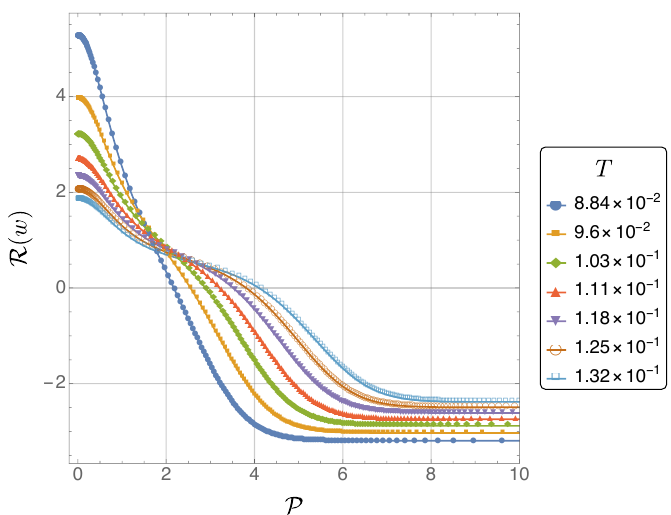
Figure 17 . Curvature of the induced horizon geometry of the novel black hole phase as a function of the proper distance, along the horizon, from the axis of rotation. This plot was generated with (cid:22) = 4 and (cid:23) = 3, and the range of temperatures are indicated in the legend.